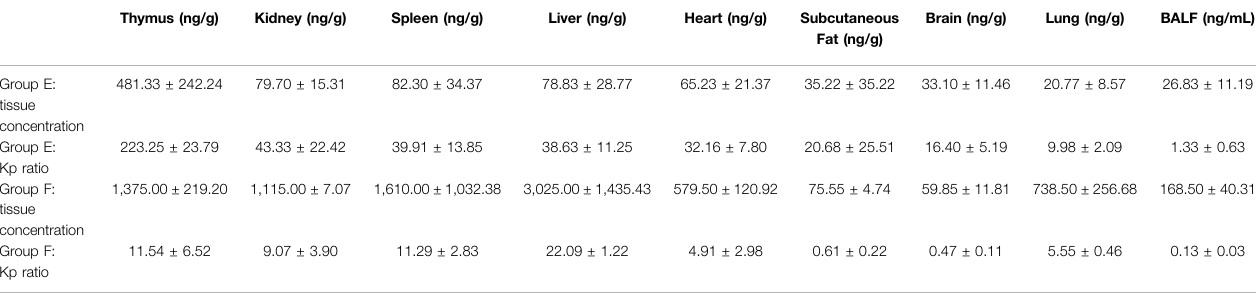
TABLE 1 | Tissues concentration (ng/g) and Kp_ tissue/blood ratio of HCQ (mean ± SD). Thymus (ng/g)